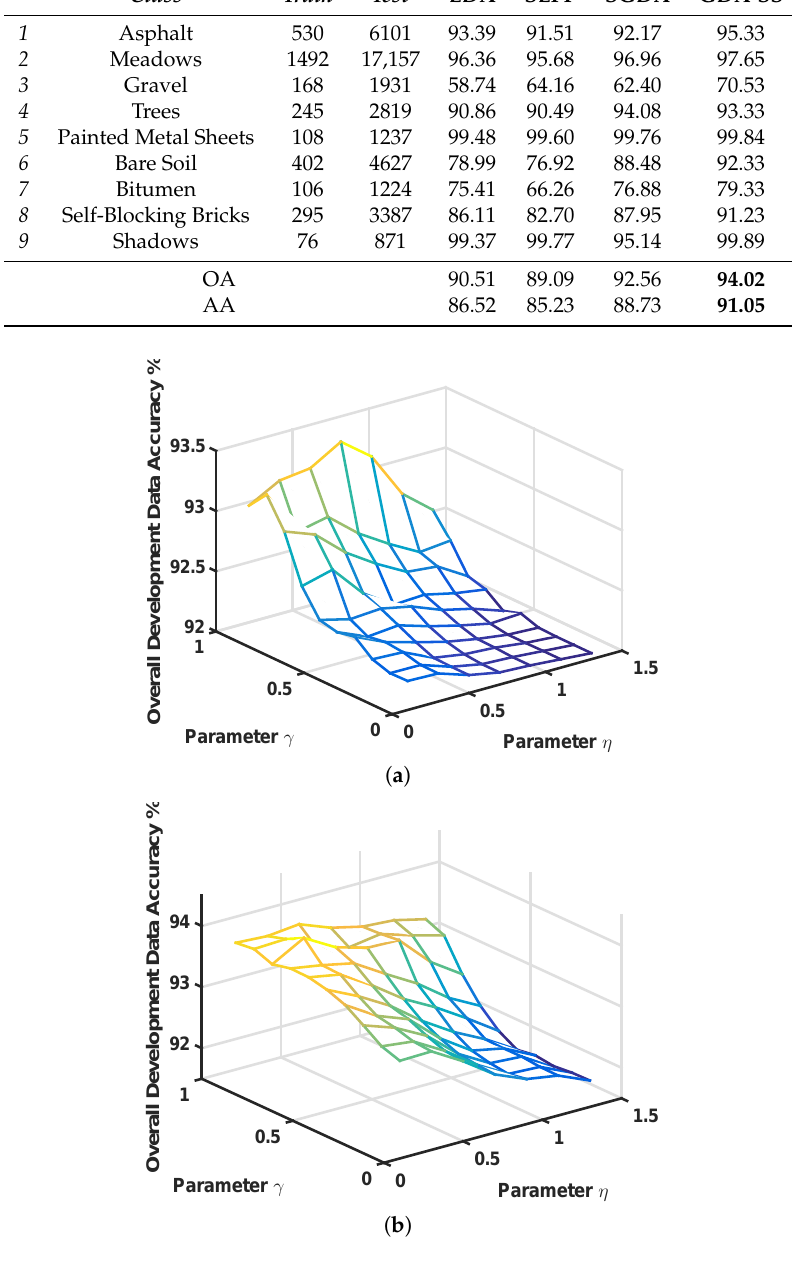
Figure 3. Parameter tuning of η and γ for the proposed GDA-SS using two experimental datasets. ( a ) Salinas; ( b ) Pavia